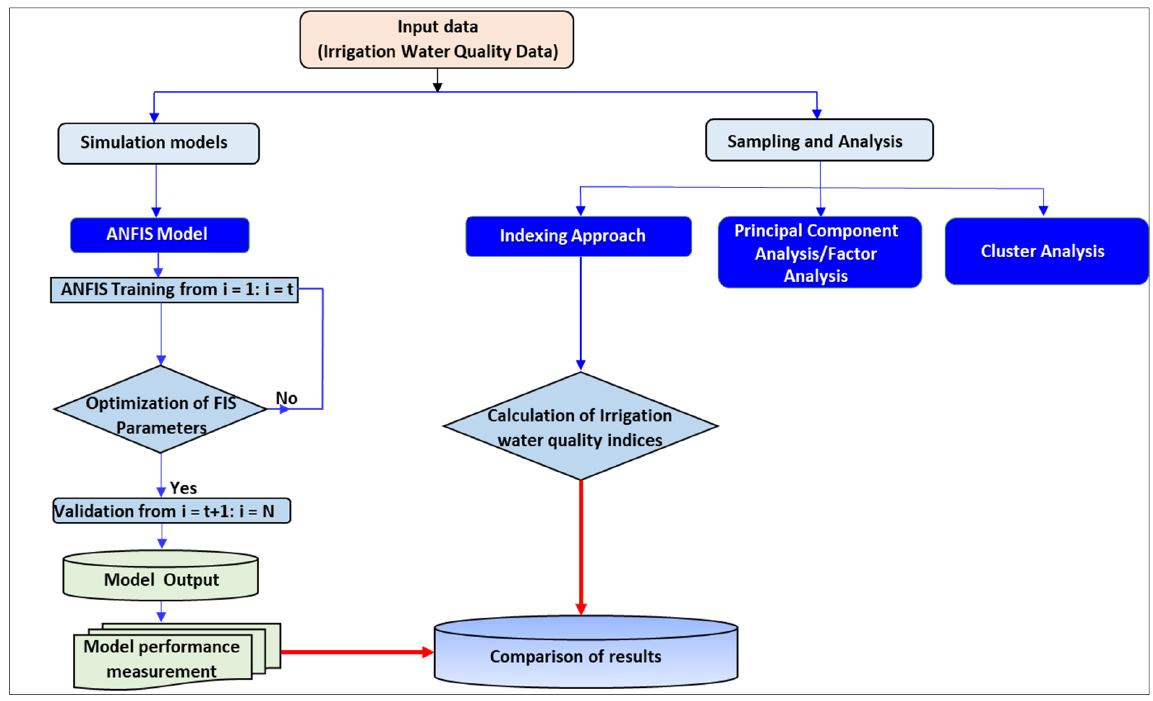
Figure 7. Schematic diagram of the methodology presented in this